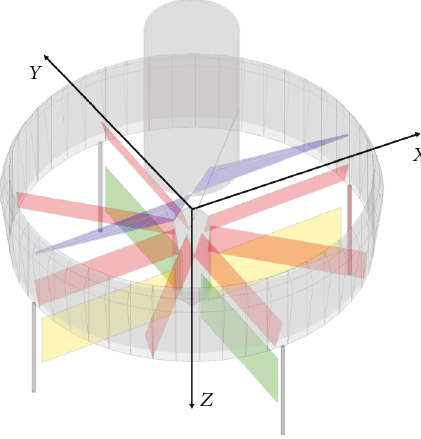
Figure 2: Simulation